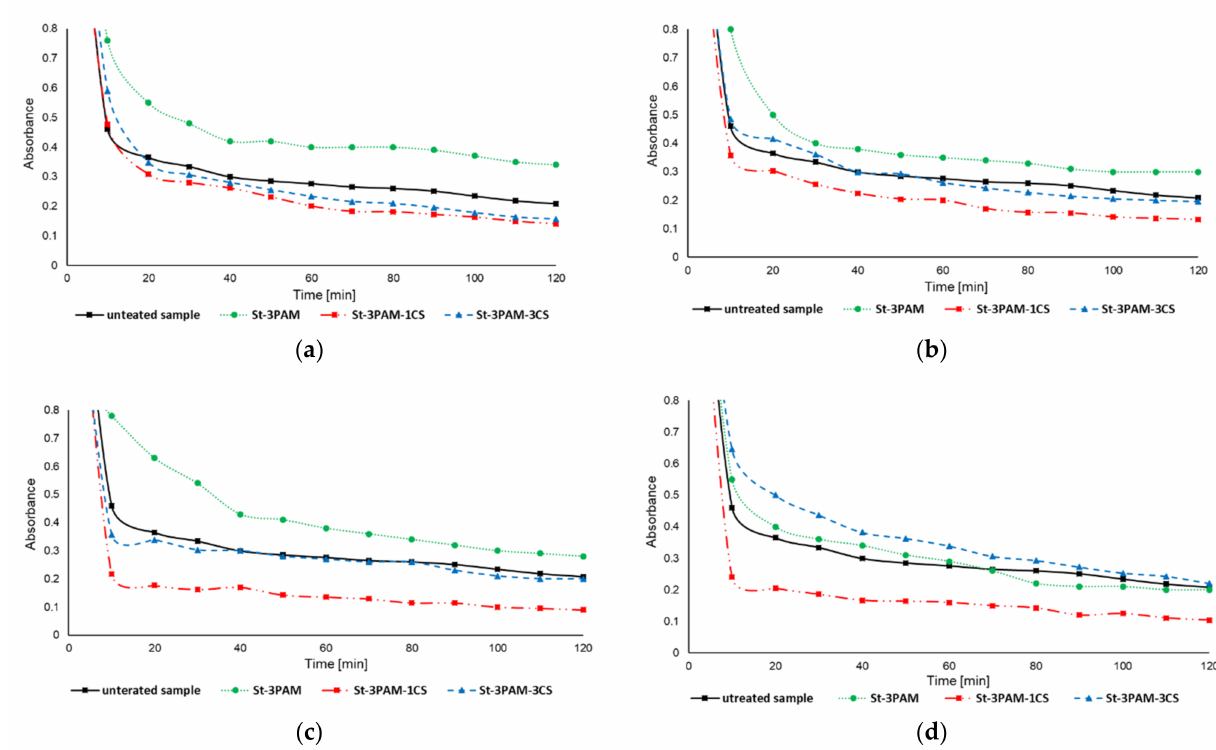
Figure 8. Absorbance for kaolin aqueous suspension as a function of time for starch grafted polyacrylamide with the St:AM molar ratio of 1:3 (St-3PAM), and its hybrids with 1 wt.% of CSs (St-3PAM-1CS) and 3 wt.% of CSs (St-3PAM-3CS) in doses: ( a ) 1 mL; ( b ) 3 mL; ( c ) 5 mL; and ( d ) 10